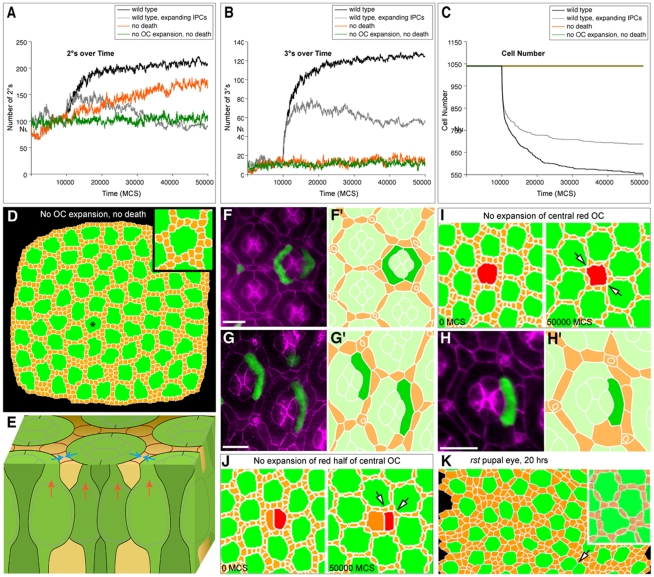
Progressive differences between IPCs and OC surface proportions promoted 2° and 3° formation.(A and B) Graphs showing formation of 2°s (A) and 3°s (B) over time for different size ratios between IPC and OC apical surface areas. Cell death was initiated at 10,000 MCS. The ‘wild-type’ curve indicates 2° and 3° formation when OC apical surfaces expanded but IPCs did not expand during progressive MCS. ‘Wild-type, growing IPCs’ indicates OCs expansion and IPC surface doubling. ‘No Death’ curve indicates expanding OCs with no cell death. ‘No OC Expansion’, No Death' curve indicates constant OC surface area (no expansion) and no cell death. (C) A graph indicating the decrease in cell number for the different simulations. Each line represents the result of a single representative simulation from at least two repetitions. (D) Image capture at 50,000 MCS from a simulation with no OC expansion nor cell death; the pattern fails to resolve; asterisk labels enlarged ommatidium (inset) (E) Three dimensional schematic emphasizing how the vertical movement of nuclei (red arrows) expands the 1°s' surface profiles (blue arrows), in turn laterally ‘crowding’ the neighboring IPCs into a hexagonal pattern. (F, G and H) Reducing OC expansion by expressing smurf introduced patterning errors in vivo. Bars represent 10 µm. (F) Ectopic expression of smurf in paired 1°s led to mild patterning defects, primarily in cell number. (G and H; corresponding tracings in G′ and H′) Reducing growth of single 1°s (marked by GFP) reduced the apical surface profile (E-Cadherin shown in magenta); the neighboring IPC arrangement and 3° cell loci failed to properly resolve. (I and J) Central region of images captured at 0 MCS and 50,000 MCS in simulations in which (I) the entire central OC indicated in red or (J) only half of the OC was prevented from expanding. Arrowheads indicate defects also commonly observed in vivo – missing or ectopic cells. (K) Reduced rst activity (rstCT) led to consistently uneven IPC distribution in 20 hr APR eyes; within this tracing, an example of a rare fused ommatidium is indicated (arrow). Inset: our computer model consistently failed to pattern this rst tracing even after 50,000 MCS The failure to pattern using the same parameters as our wild type tracing indicates that the 20 hr APF rst eye field must already show differences with wild type tissue.